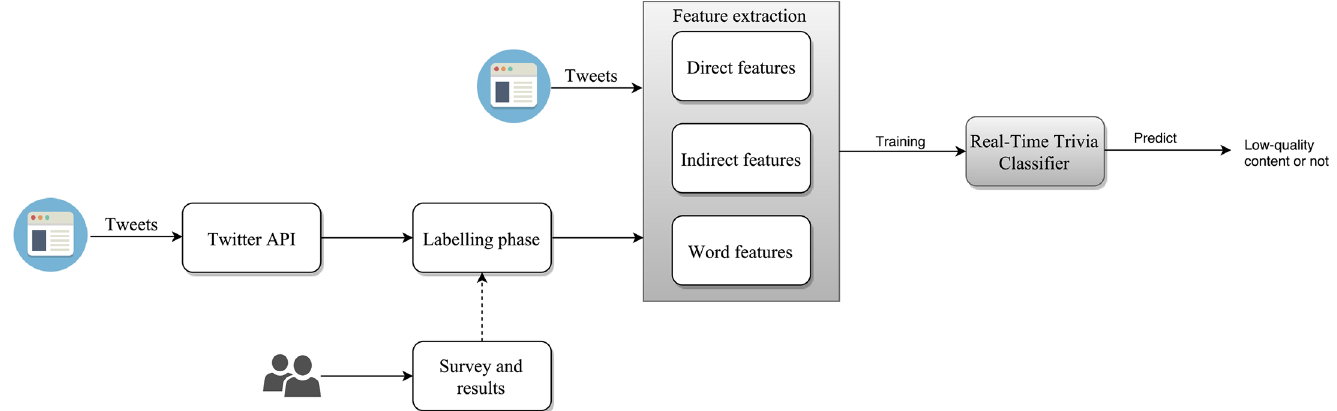
Fig 1. Overviewof the low-quality content detection system.